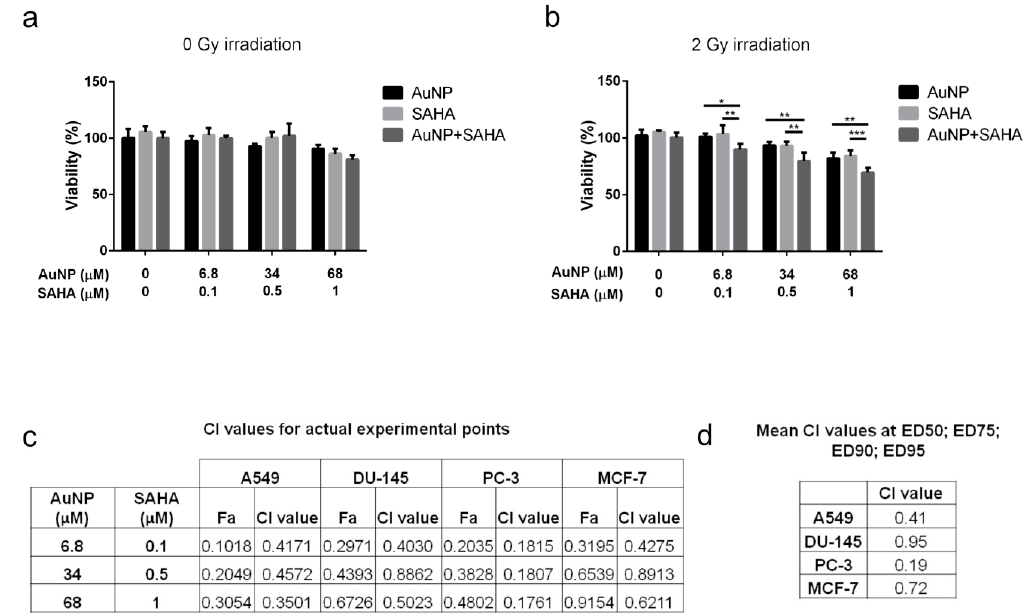
Figure 4. The effect of AuNP, SAHA and the combination of AuNP and SAHA on cell viability: ( a ) without irradiation, no differences in the viability of A549 cells were observed after AuNP, SAHA and AuNP + SAHA treatments. ( b ) After 2 Gy irradiation the viability of A549 cells were significantly decreased in the AuNP + SAHA-treated samples compared to control and to the individual treatments. (* p value < 0.05; ** p value < 0.01; *** p value < 0.001; two-way analysis of variance (ANOVA) Tukey’s multiple comparisons test). ( c ) Combinational indices (CI) for the actual experimental points of the combinational treatments were under 1, suggesting synergism between AuNPs and SAHA in all tested cell lines. ( d ) The mean CI values obtained from ED50, ED75, ED90 and ED95 of A549, DU-145, PC-3 and MCF-7 cell lines indicate synergistic interaction between AuNPs and SAHA in combinational administration.